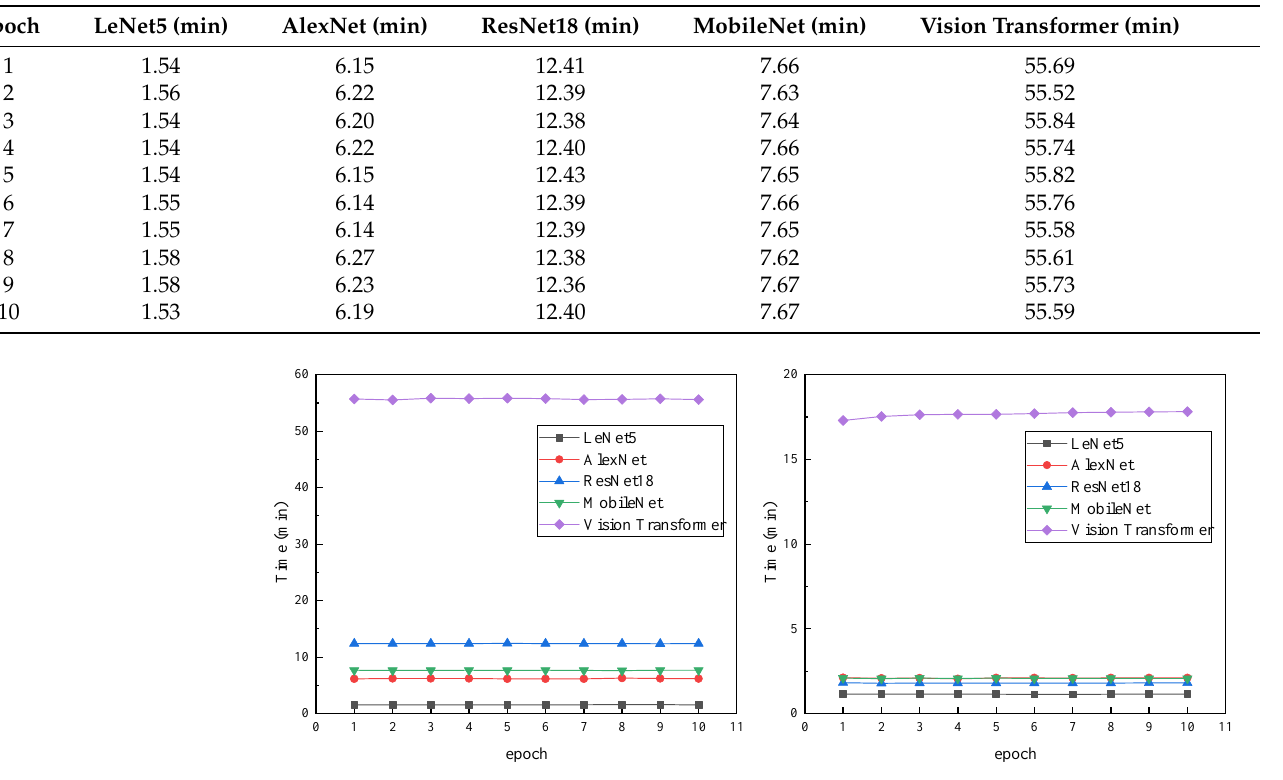
Table 11. Computational efficiency of per epoch operation for each model after data augmentation and before GPU loading.